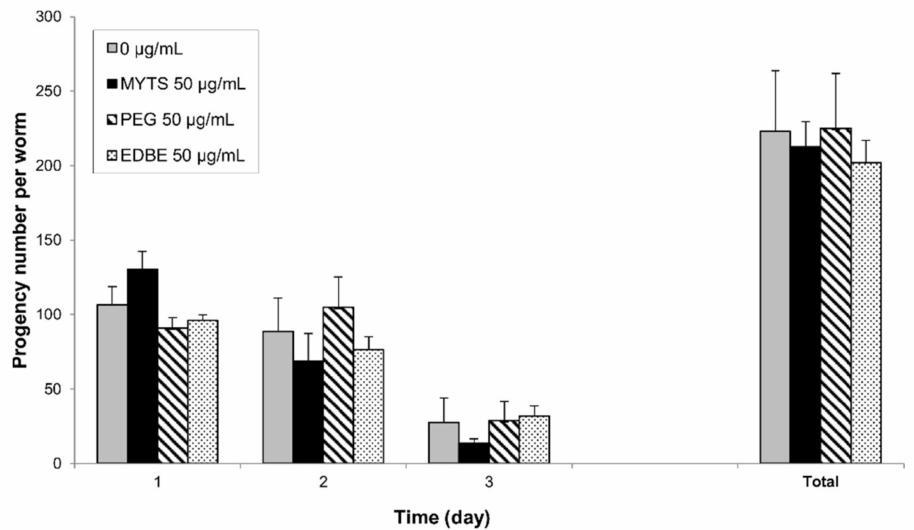
Figure 8. Effect of NPs on C. elegans reproduction. Synchronized young adult worms were placed onto NGM plates with or without 50 µ g/mL of unconjugated MYTS, MYTS-PEG or MYTS-EDBE and individually transferred to a new plate each day until they stopped to lay eggs. Time-course distribution of fertility and total number were determined. Error bars represent the standard error (SE). The Student’s t -test did not reveal any significant difference among the